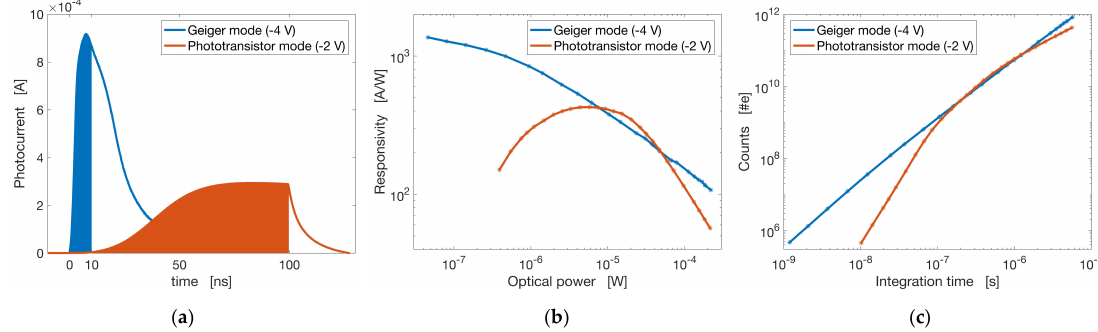
Figure 4. Photo-response of a 20 µ m EI detector based on the architecture reported in [28], at 1 µ W illumination power, in Geiger mode and phototransistor mode operation, corresponding for this device to applied bias of –4 V and –2 V respectively. ( a ) Time-resolved photo-response in the two operating modes: the shaded areas represent the charge accumulated on the detector during integration times T int of 10 ns and 100 ns for Geiger and phototransistor mode respectively. ( b ) Responsivity R I of the same device, as a function of optical illumination power, in the two operating regimes. ( c ) Electron count N e as a function of read-out integration time, obtained from the data in ( b ) by considering a constant illumination Φ 0 : so that N e = R I Φ 0 T int